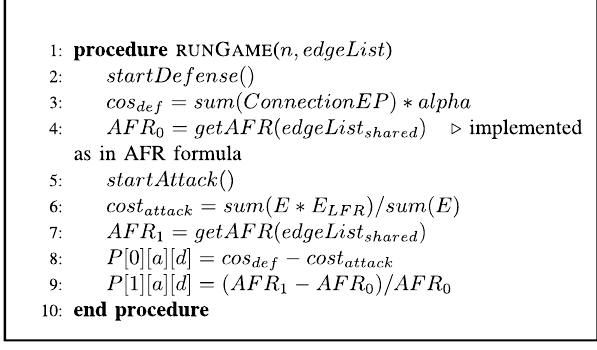
Figure 3. Pseudocode for game.